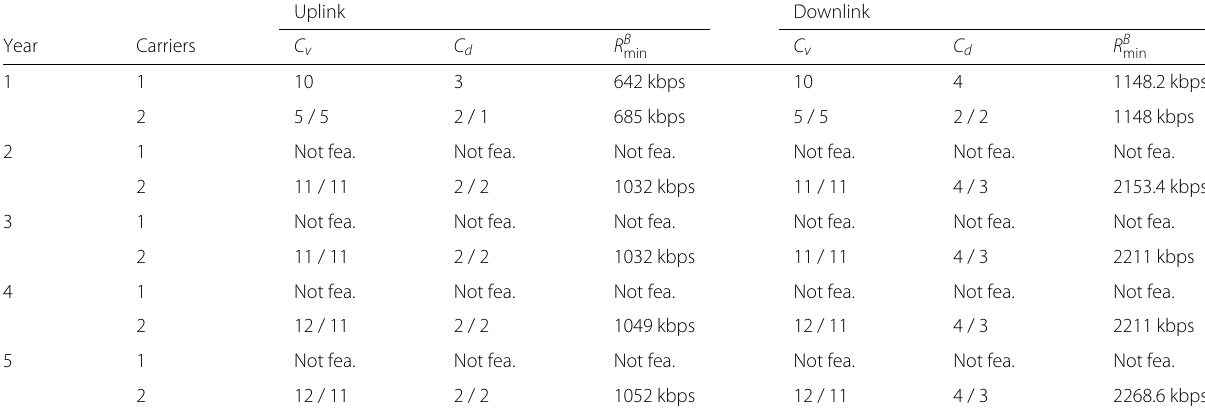
Table 4 Optimum limits on the number of simultaneous connections and backhaul bandwidth (San Gabriel) Uplink